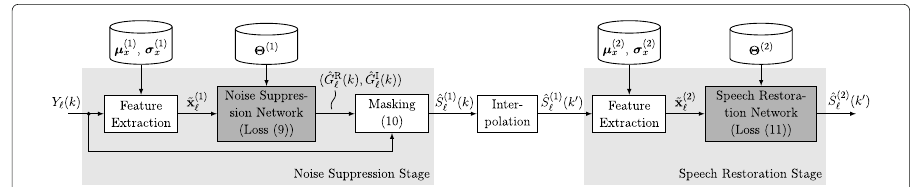
Fig. 1 Block diagram of the proposedtwo-stageenhancementapproach including the first-stage noise suppression, followed by the second-stage speech restoration used to restore a natural sounding speech signal. For details on the noise suppression network block and the speech restoration network block refer to Figs. 2 and 3,